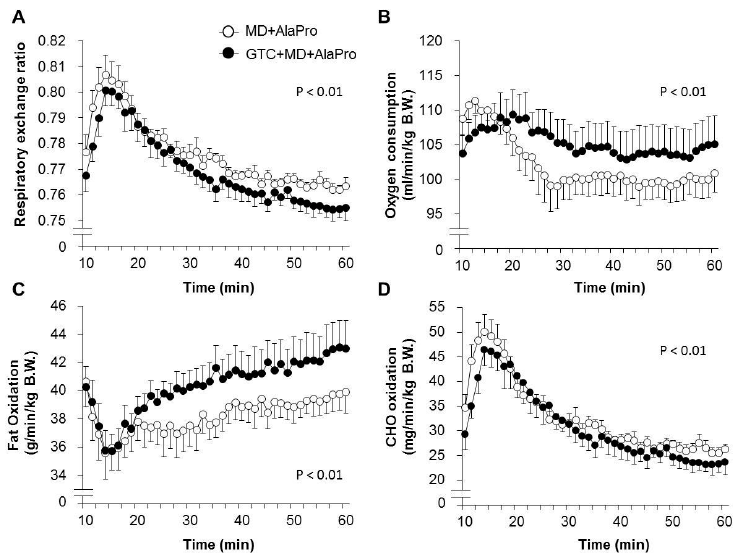
Figure 3. Energy metabolism during running exercise. ( A ) RER, ( B ) oxygen consumption, ( C ) fat oxidation, and ( D ) CHO oxidation were measured by indirect calorimetry during a 60-min treadmill running exercise as described in the Methods section. Mean values for each time points are plotted. Values are means ± SE ( n = 8). P values reflect between-group differences assessed by two-way repeated-measures ANOVA during the 50-min running period at 20 m/min.